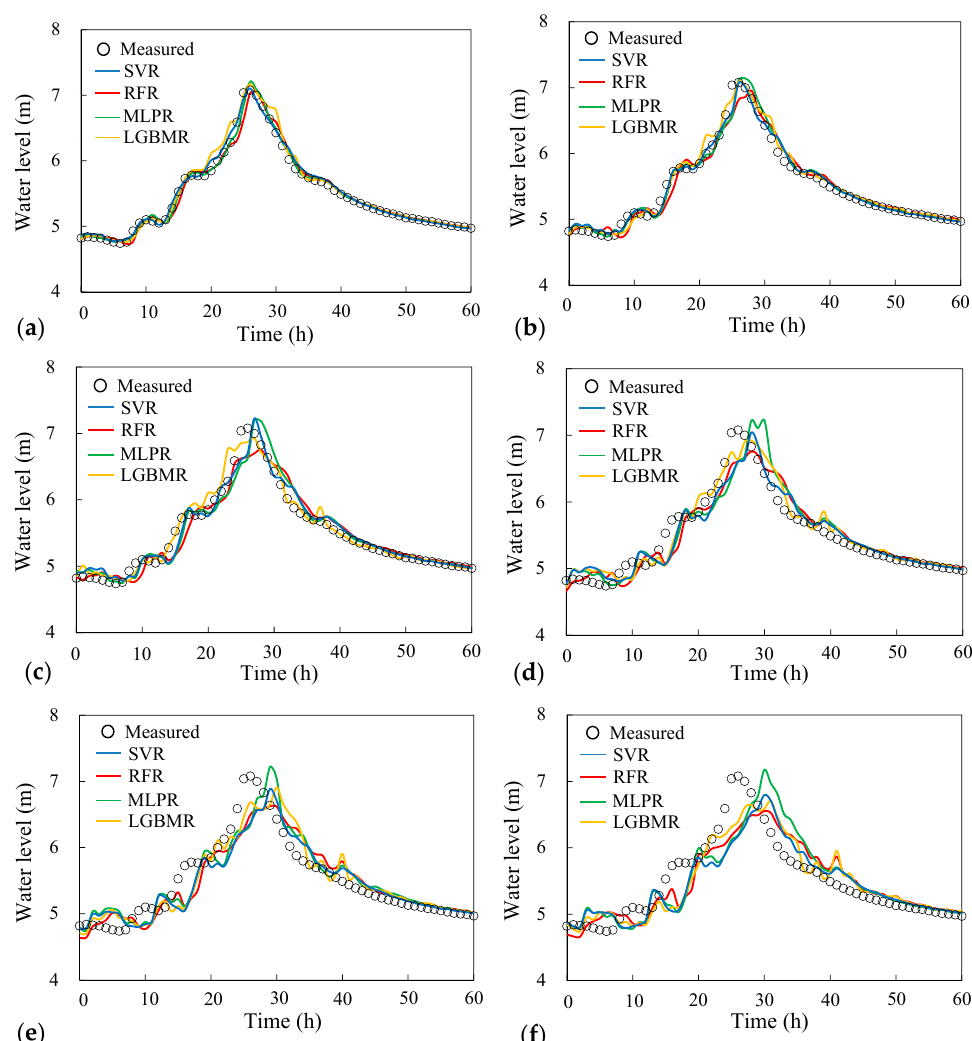
Figure 9. The comparison of measured and forecasted river stages at Simon station for Typhoon Saola with ( a ) 1-, ( b ) 2-, ( c ) 3-, ( d ) 4-, ( e ) 5-, and ( f ) 6-h lead times.